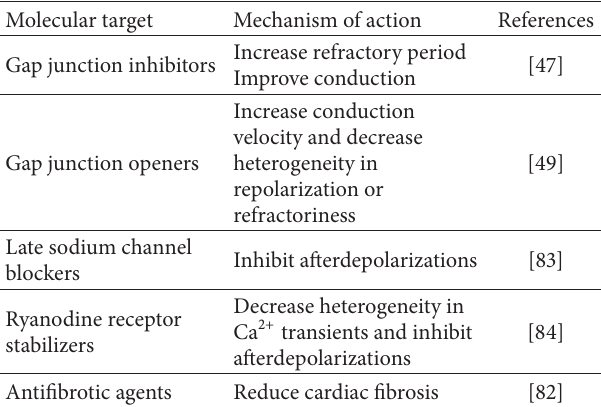
Molecular target Mechanism of